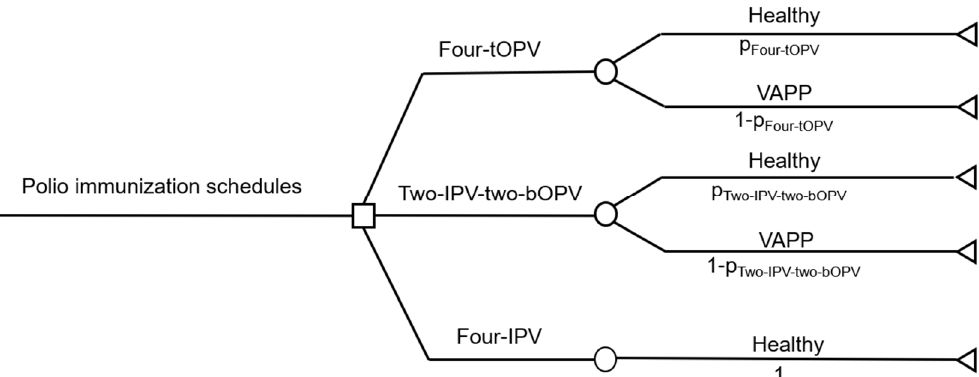
Figure 1. A decision tree model for cost-effectiveness analysis of three polio immunization schedules. The decision tree model had the following hypotheses: (1) 100% coverage of polio immunization in the study population; (2) no self-paid polio-containing vaccines in the study population; (3) no occurrence of VAPP after four-IPV immunization in the study population; (4) cost of cold-chain services, human resources, and administration remain identical across three polio immunization schedules. IPV, inactivated polio vaccine; VAPP, vaccine-associated paralytic poliomyelitis.